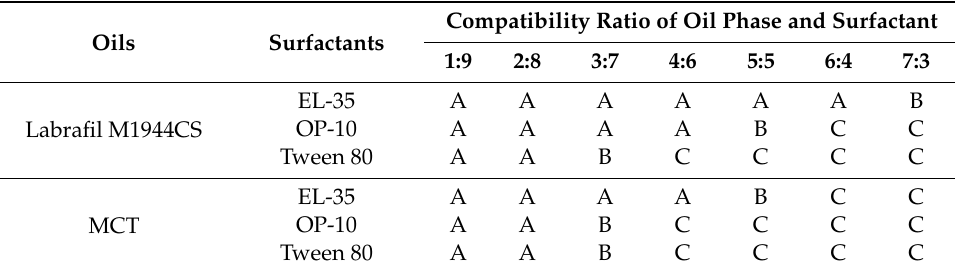
Table 3. Visual grading results of self-microemulsification e ffi ciency.